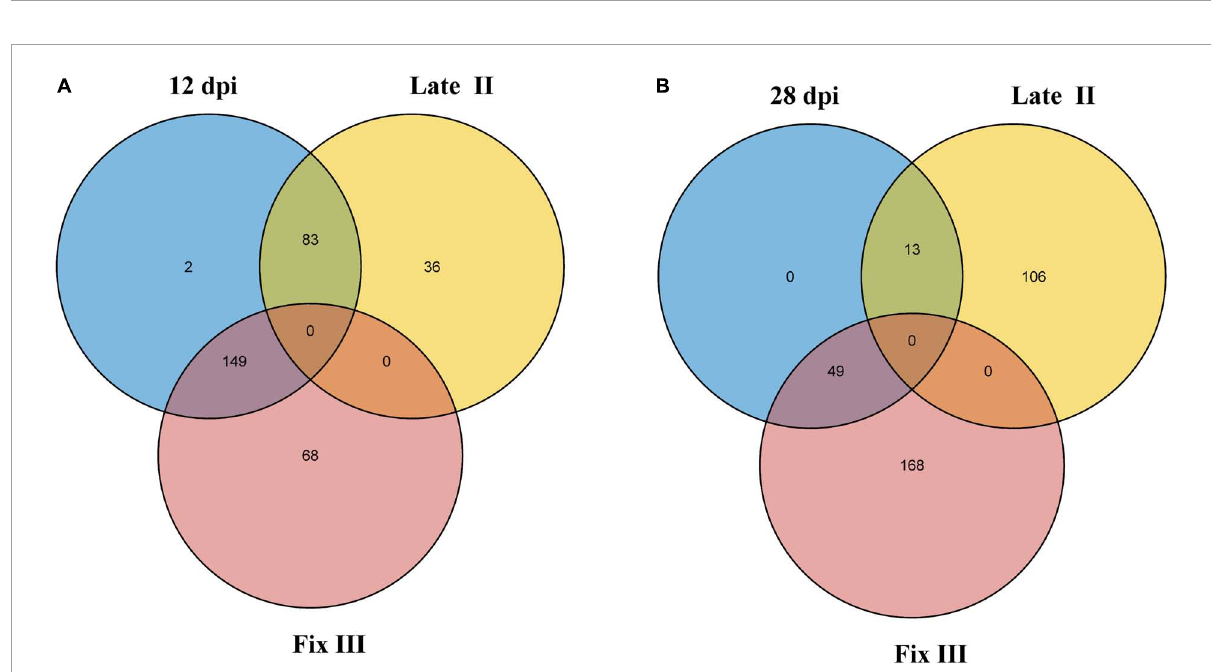
FIGURE6 Intersection of NCR genes with expression maximum at different dpi and different nodule zones. (A) Intersection of NCRs with maximum expression at 12 dpi and with maximum expression in late II and III zones. (B) Intersection of NCRs with maximum expression at 28 dpi and with maximum expression in late II and III